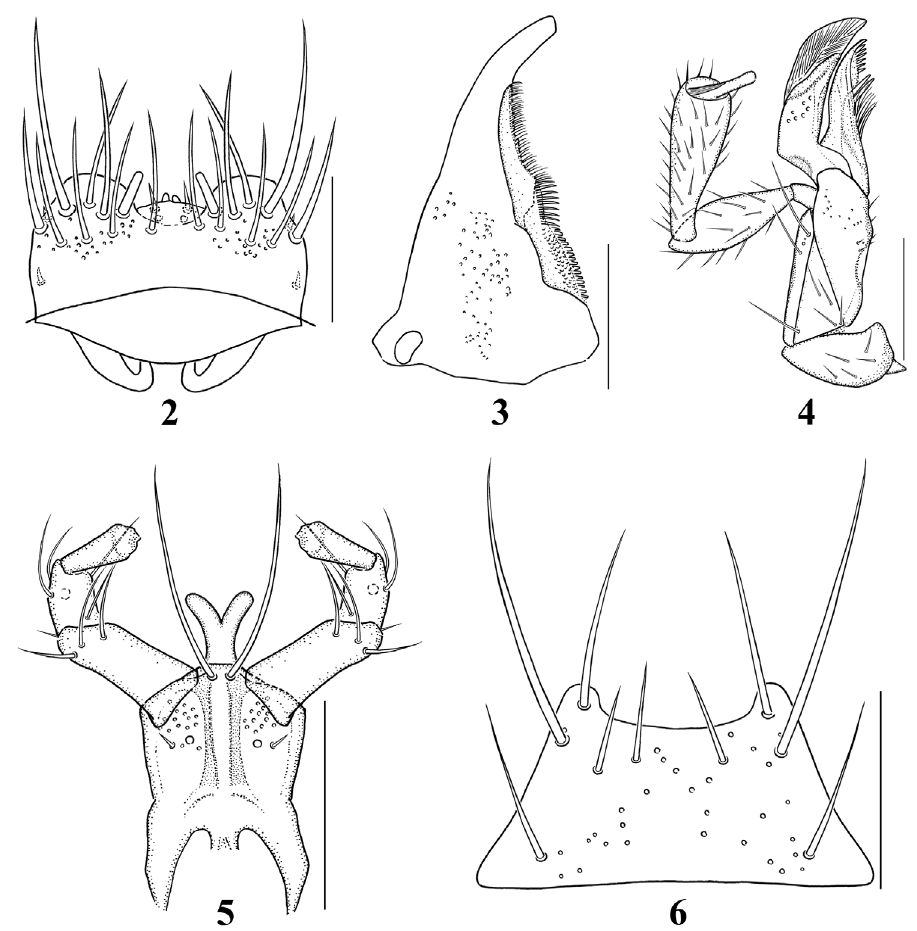
Figures 2–6. Mouthparts of Iotarphia rufobrunnea sp. n.: 2 labrum, dorsal aspect 3 right mandible, ventral aspect 4 right maxilla, ventral aspect 5 labium, ventral aspect 6 mentum, ventral aspect. Scale bars = 0.1